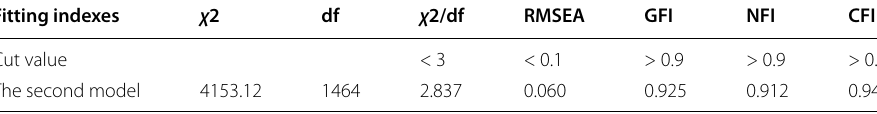
Table 4 Model fit indices (model